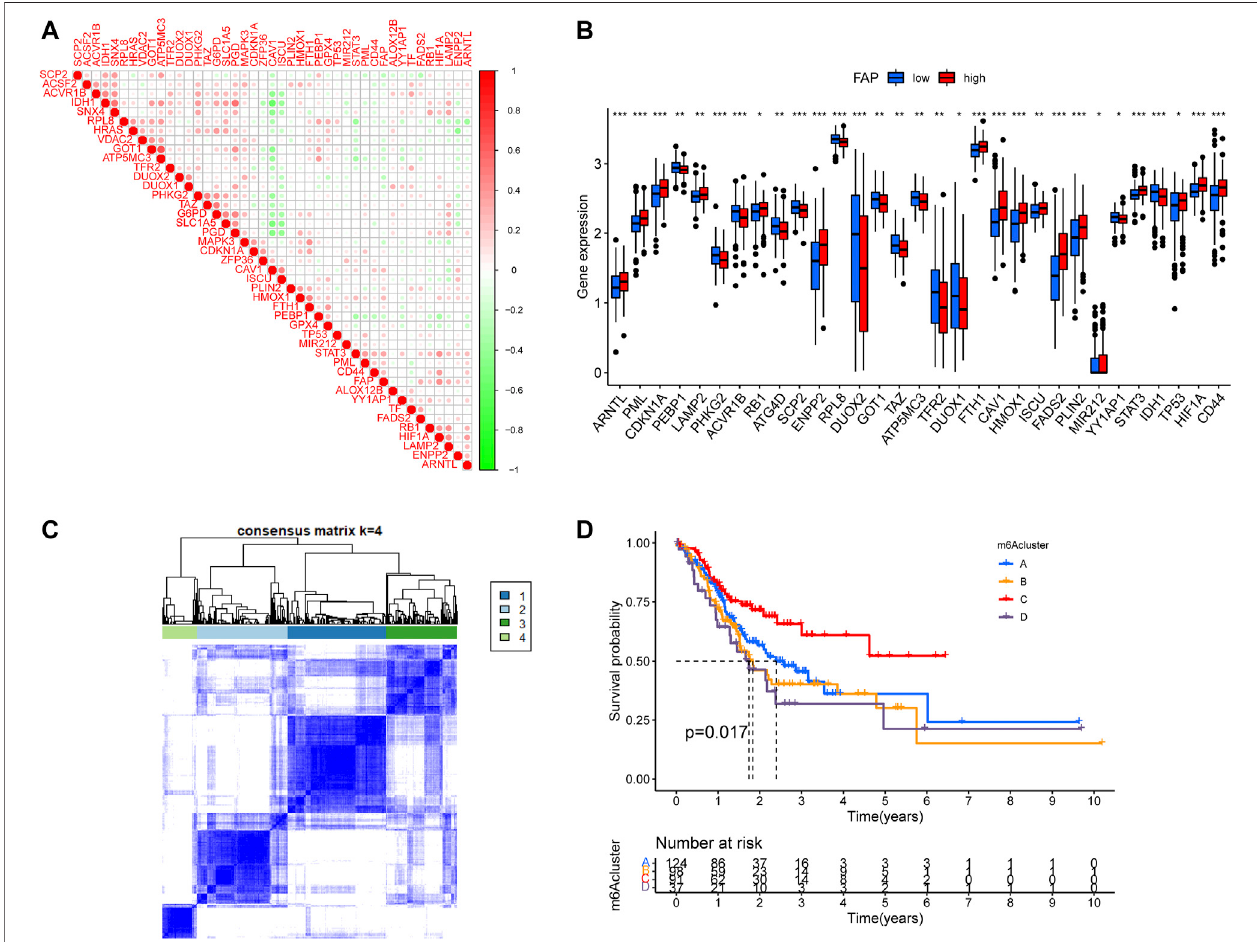
FIGURE5| Consensusclusteringofferroptosis-relatedgenes. (A) CorrelationsbetweenFAPandknownFRGsintheTCGA-STADcohort. (B) Expressionlevelsof FRGsinFAP-highandFAP-lowgroups;* p < 0.05,** p < 0.01,*** p < 0.001. (C) Consensusclusteringmatrixfor k =4. (D) Kaplan – Meiersurvivalanalysisforpatientsinthe four ferroptosis-related